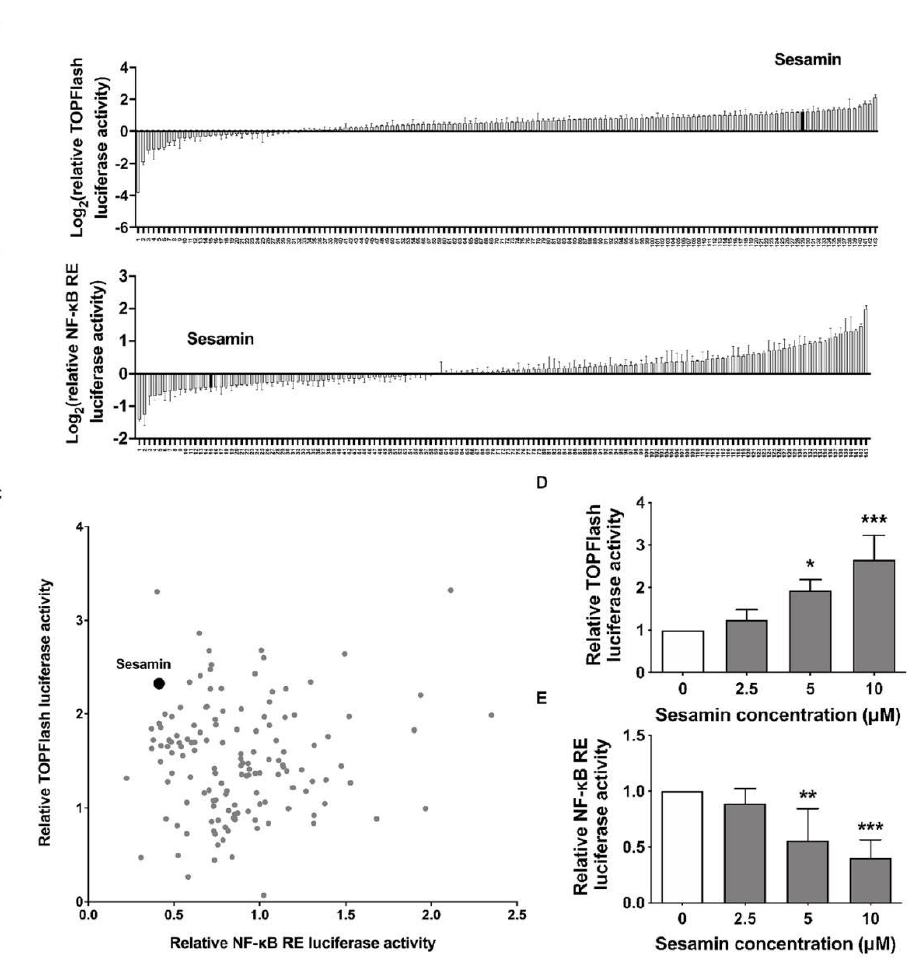
Figure 1. Screening of small molecules repressing luciferase activity of TOPFlash and NF- κ B response element system. ( A , B ). Luciferase activities of TOPFlash ( A ) and NF- κ B response element ( B ) reporter system upon small molecule library treatment. The fold changes of sesamin-regulated luciferase activity were highlighted. ( C ). Two-dimensional diagram with both luciferase reporter activities were plotted and sesamin was highlighted. ( D , E ). Luciferase activity of TOPFlash ( D ) and NF- κ B response element ( E ) reporter system were decreased upon treatment with sesamin at different concentrations ( n = 6; * p < 0.05, ** p < 0.01, *** p < 0.001).